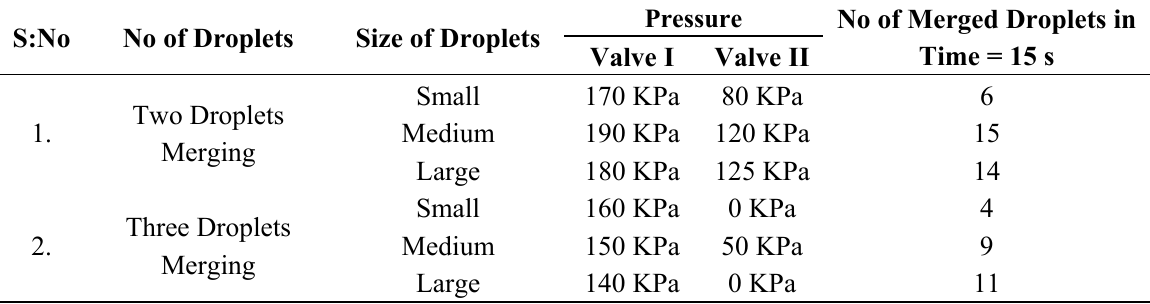
Table 2. Two and three (small, medium and large) number of merged droplets with respect to